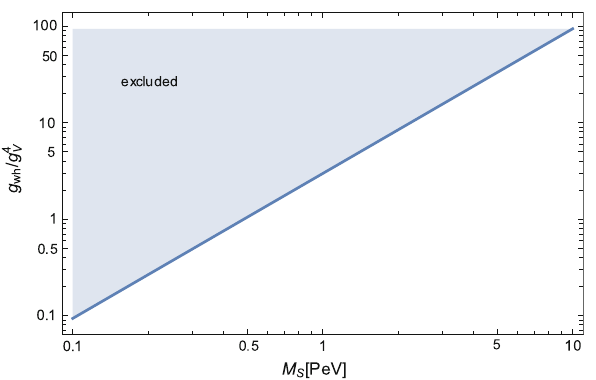
Fig. 7 Direct search constraints on very heavy dark skyrmion param- eters from the XENON1T 1-year results